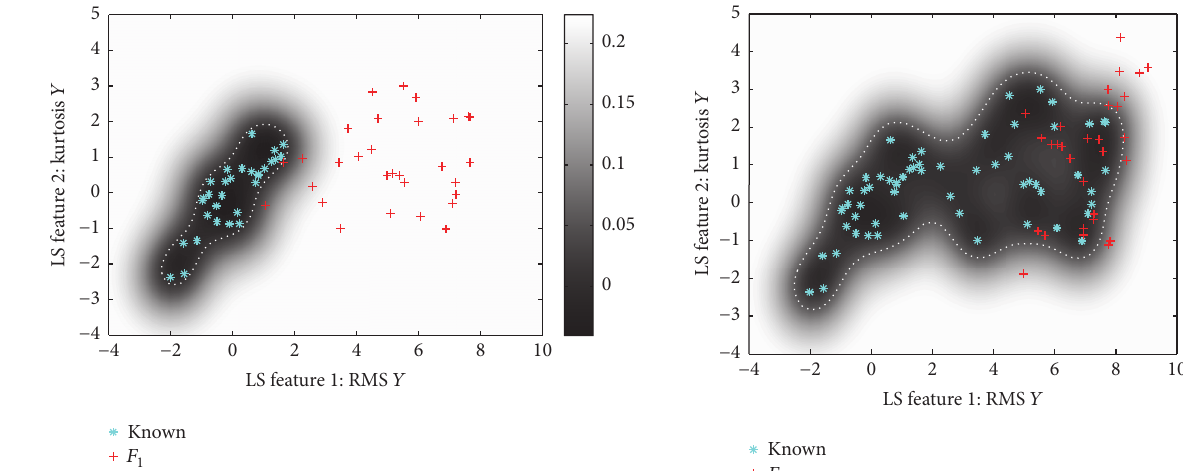
Figure 8: Evaluation of the fault scenario 𝐹 2 . The novelty model is trained employing data from healthy and 𝐹 1